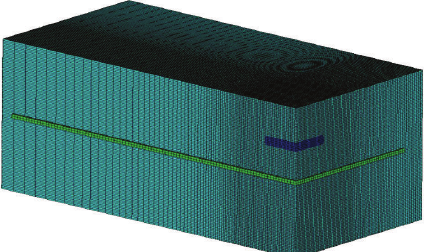
Figure 5: One-quarter finite element models of quadrangular plate and air field.